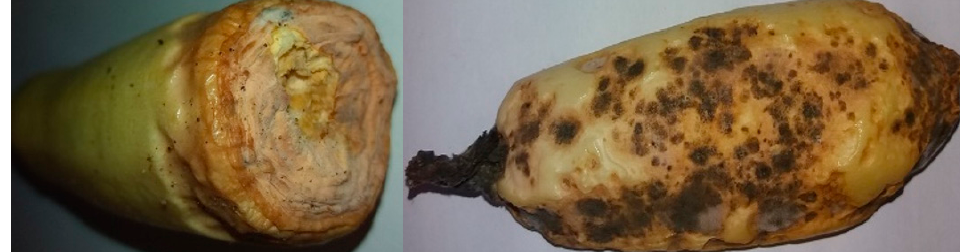
Figure 1. Symptoms of fungal diseases in naturally infected zucchini plants.